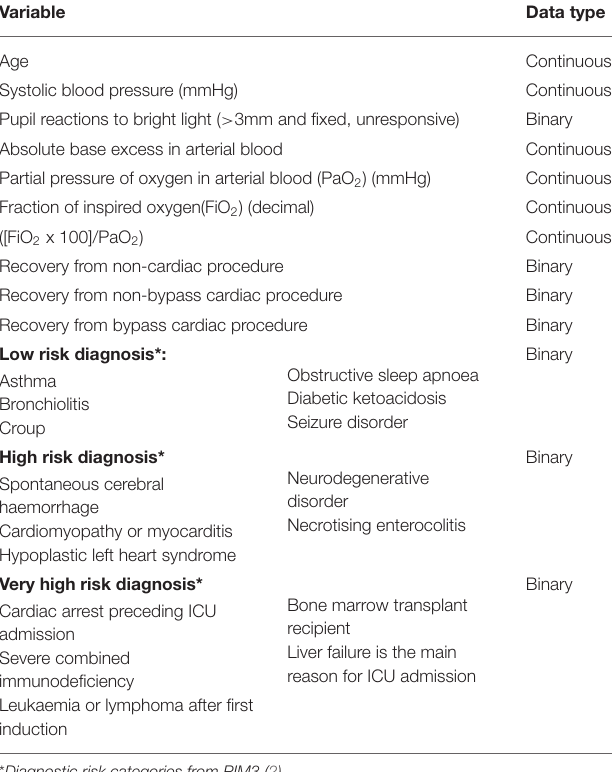
TABLE 1 | Variables